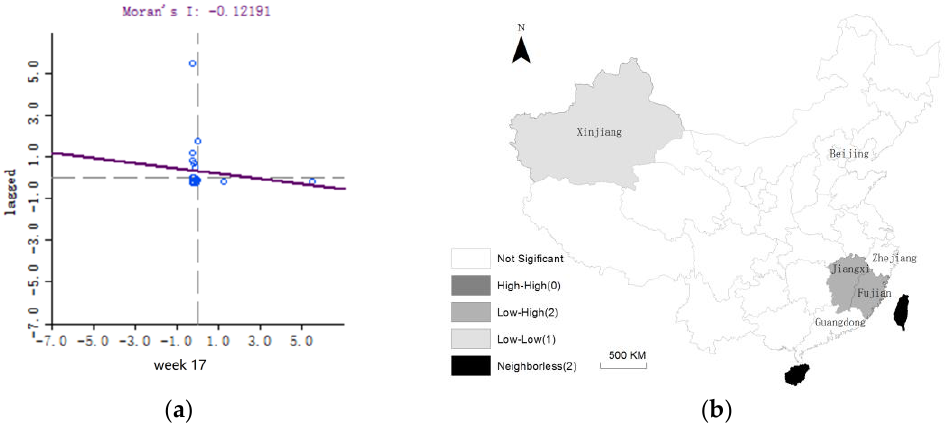
Figure 12. Local Moran’s I ( a ) scatter plot; ( b ) cluster map.